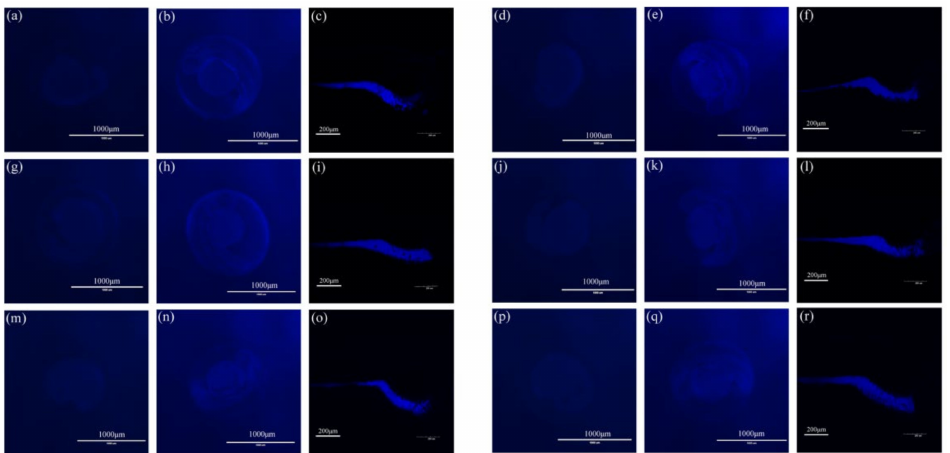
Figure 10. Fluorescence images of zebrafish embryos after soaking with compounds ( a ) 1 , ( d ) 2 , ( g ) 3 , ( j ) 4 , ( m ) 5, and ( p ) 6 (15 µ M) for 1 h at 24 hpf. Fluorescence images of zebrafish embryos after soaking with compounds ( b ) 1 , ( e ) 2 , ( h ) 3 , ( k ) 4 , ( n ) 5 , ( q ) 6 (15 µ M) for 1 h at 48 hpf. Fluorescence images of zebrafish embryos after soaking with compounds ( c ) 1 , ( f ) 2 , ( i ) 3 , ( l ) 4 , ( o ) 5 , ( r ) 6 (15 µ M) for 1 h at 120